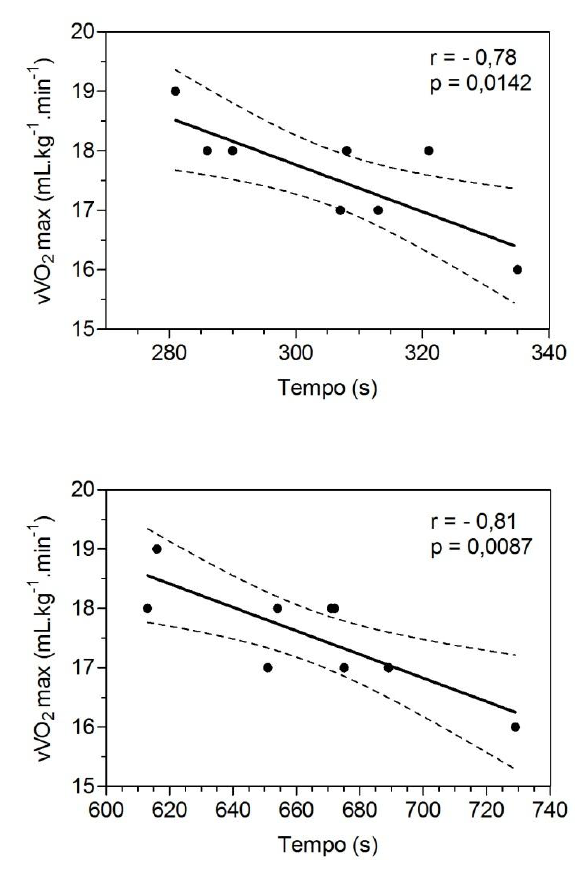
Figura 1 . Correlação da vVO